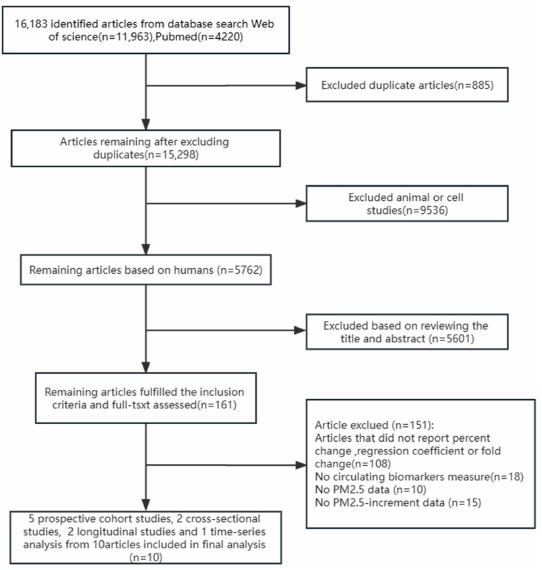
Figure 1. Flow diagram for the identification of relevant studies.